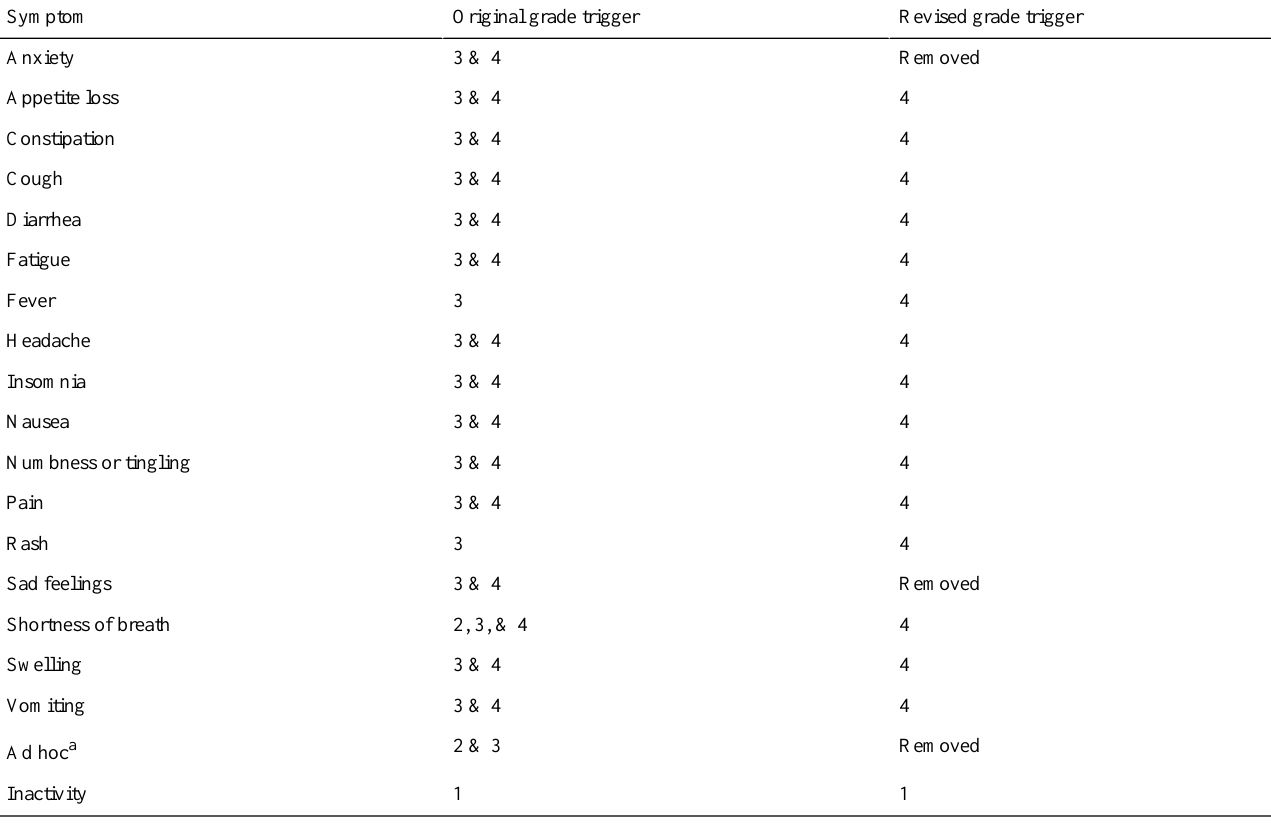
Table 1. Selected Patient-Reported Outcomes Common Terminology Criteria for Adverse Events symptom list and alert